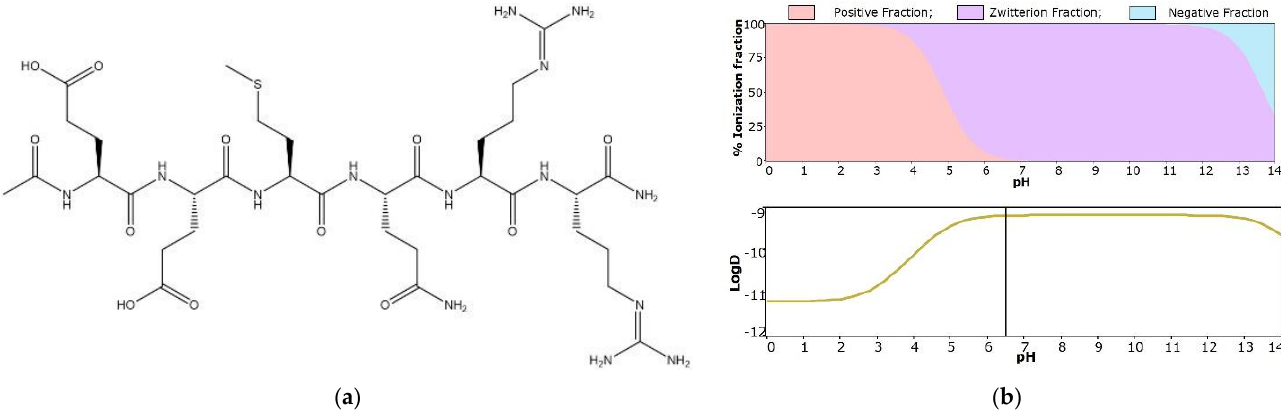
Figure 1. Acetyl hexapeptide-8 ( a ) Chemical structure; ( b ) Plots of the ionization fraction ( top ) and the LogD values ( bottom ) as a function of pH.